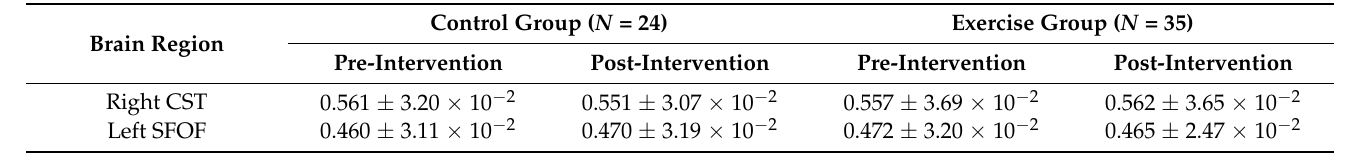
Figure 1. Brain regions with significant interaction effects on FA ( p < 0.05). Abbreviations: R.CST, right corticospinal tract; L.SFOF, left superior fronto-occipital fasciculus. Table 3. FA values of the brain regions with interaction (M ± SD).